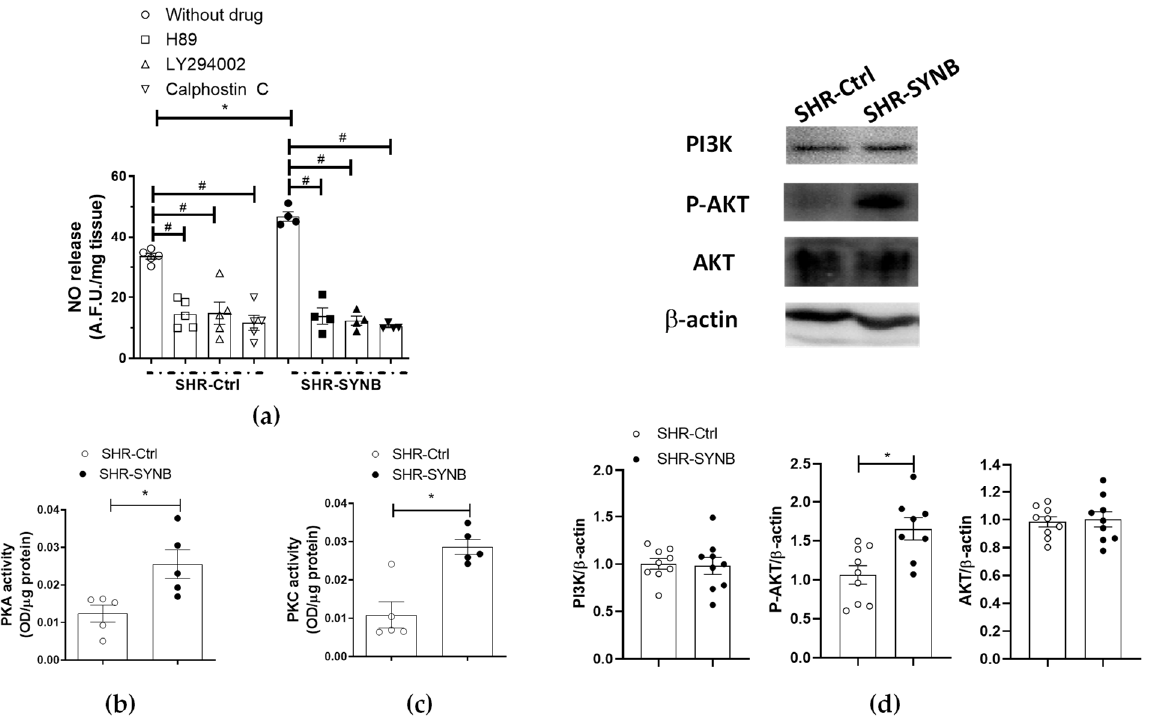
Figure 5. ( a ) Inhibitory effect of H89 (PKA inhibitor, 1 µmol/L), calphostin C (PKC inhibitor, 0.1 µmol/L) or LY 294002 (PI3K inhibitor, 10 µmol/L) on EFS-induced NO release in endothelium-